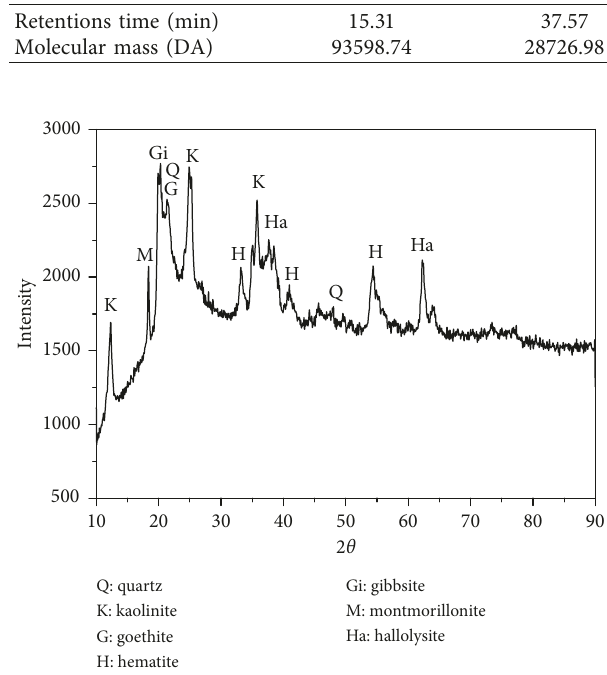
Figure 3: X-ray diffraction pattern of